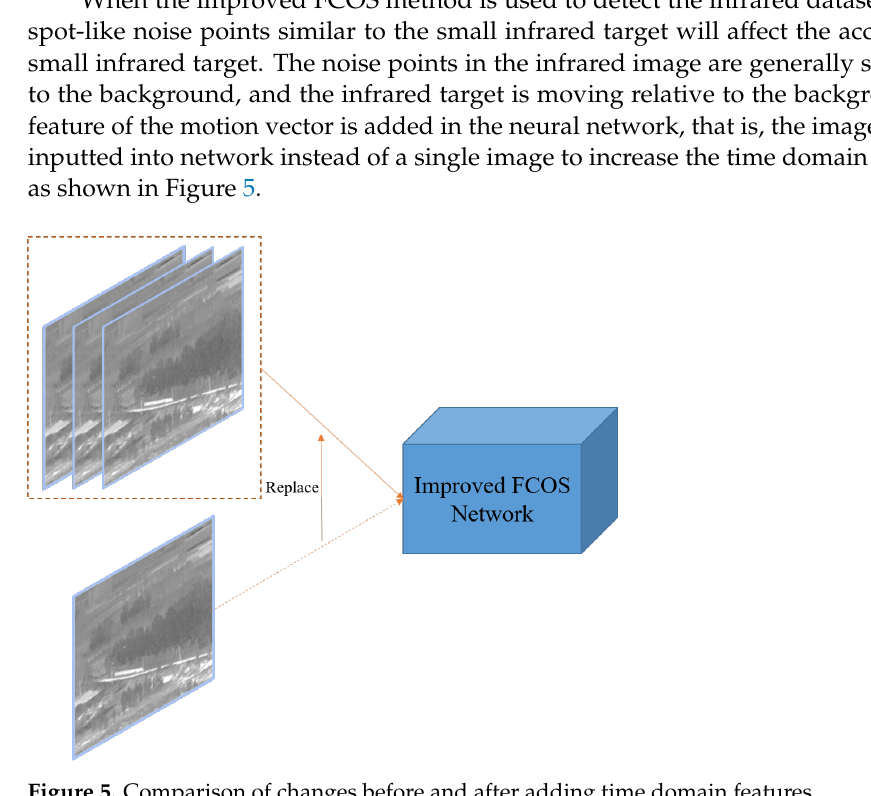
Figure 5. Comparison of changes before and after adding time domain